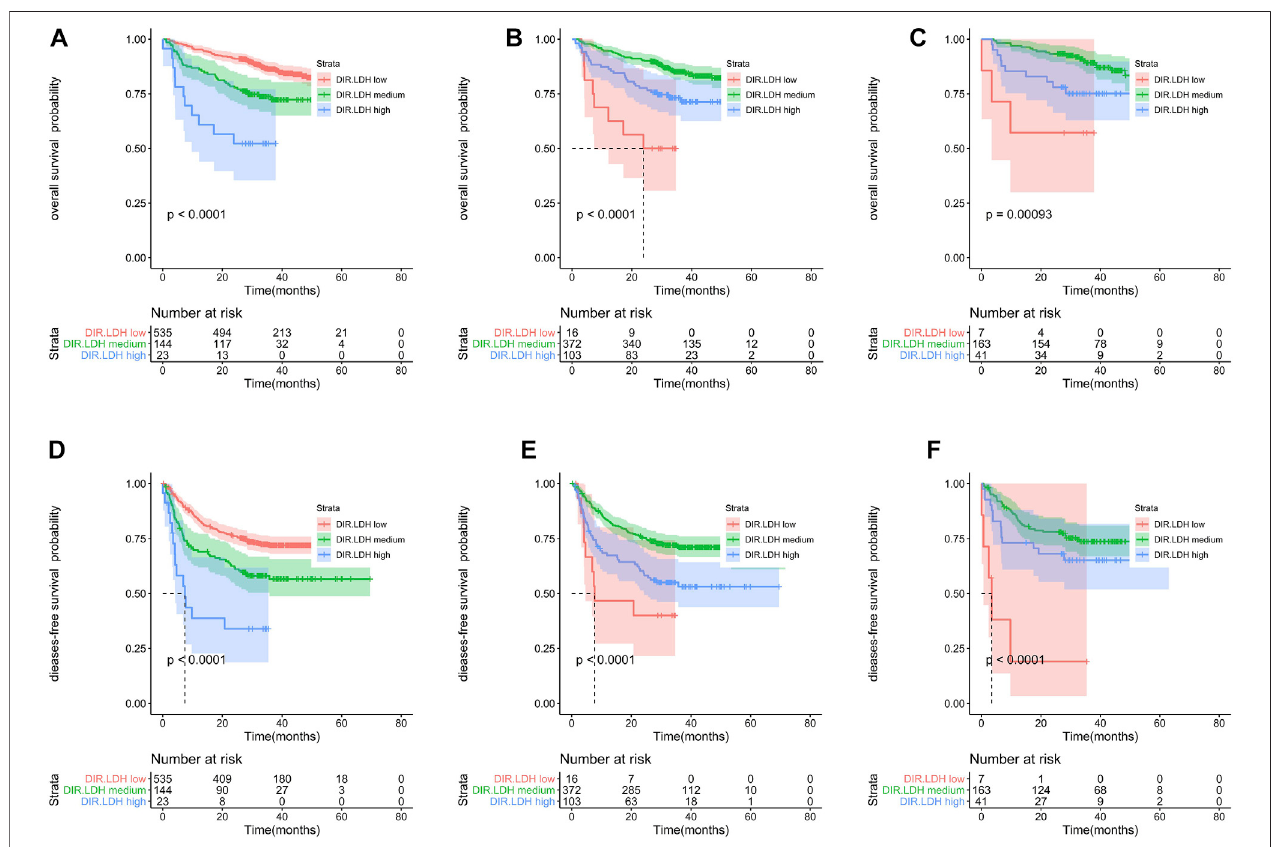
FIGURE1| Kaplan-MeiersurvivalanalysesofDIR.LDHinthewholecohort (A,D) ,trainingcohort (B,E) andtestingcohort (C,F) .Abbreviations:DIR,directbilirubin/ indirect bilirubin; LDH, lactate dehydrogenase; DIR.LDH, the combination of DIR and LDH.